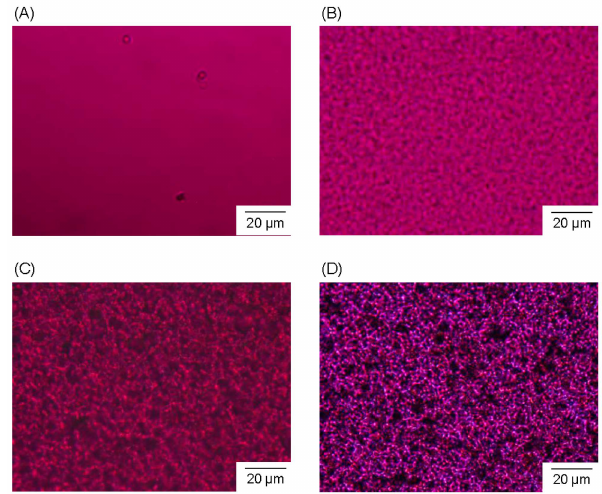
Figure 6. Polarized optical micrographs of fabrication process of the P3HB3HH 6 monolith (100 g ¨ L ´ 1 ): ( A ) 0 min; ( B ) 5 min; ( C ) 60 min; and ( D ) one day after